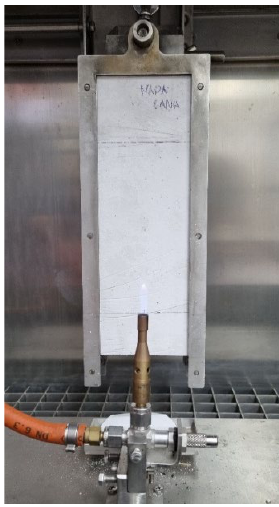
Figure 22. Ignitability test machine set up (UNE-EN-11925:1).